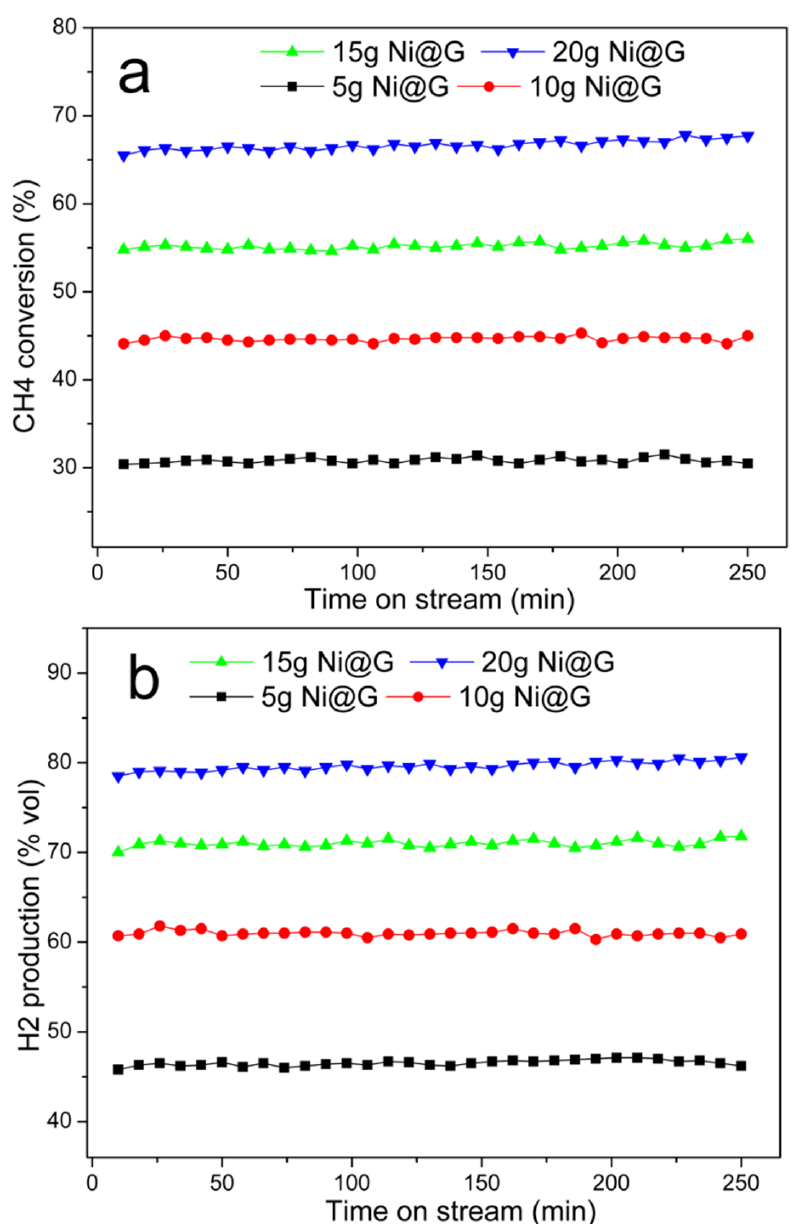
Figure 7. CH 4 conversion and H 2 production with different amounts (5g, 10 g, 15 g, and 20 g) of 25.5% Ni@G catalyst loaded in the reactor. ( a ). CH 4 conversion rate (%) vs. time, ( b ). H 2 vol% in vent gas vs. time. Testing temperature: 800 ◦ C; gas flow rate: 100 mL/min.